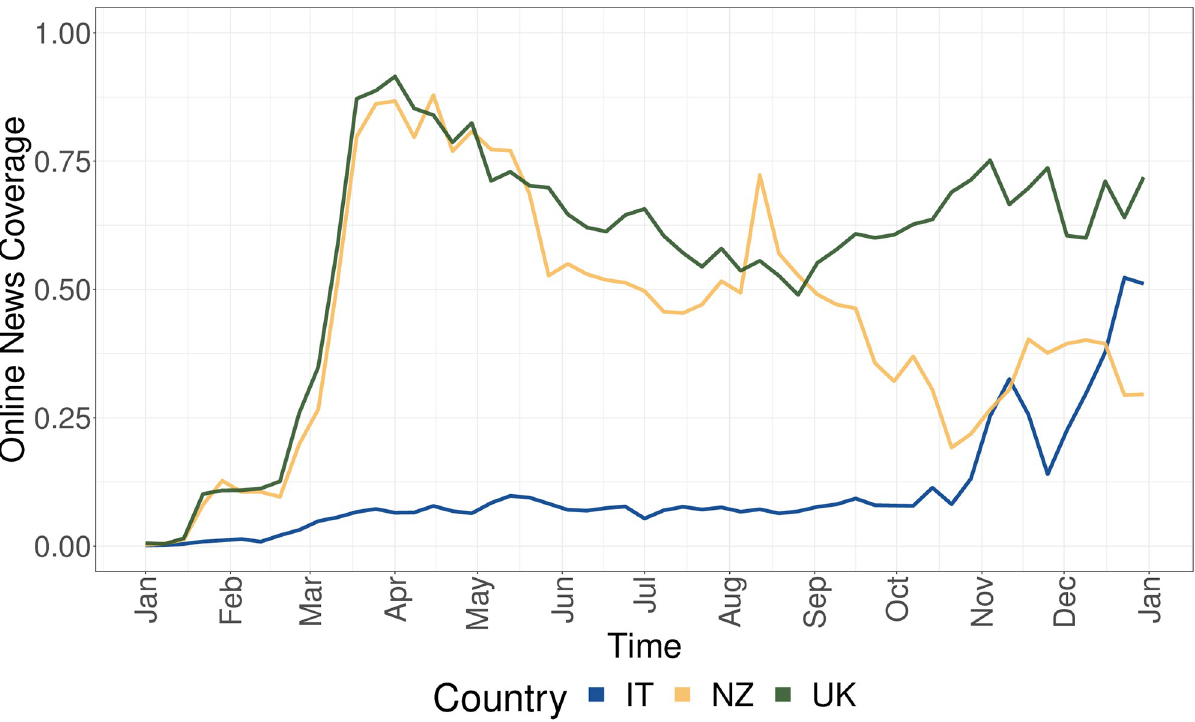
Fig 3. Evolution of the normalized Online News Coverage Index (ONCI) for Italy (blue), New Zealand (yellow) and the United Kingdom (green).